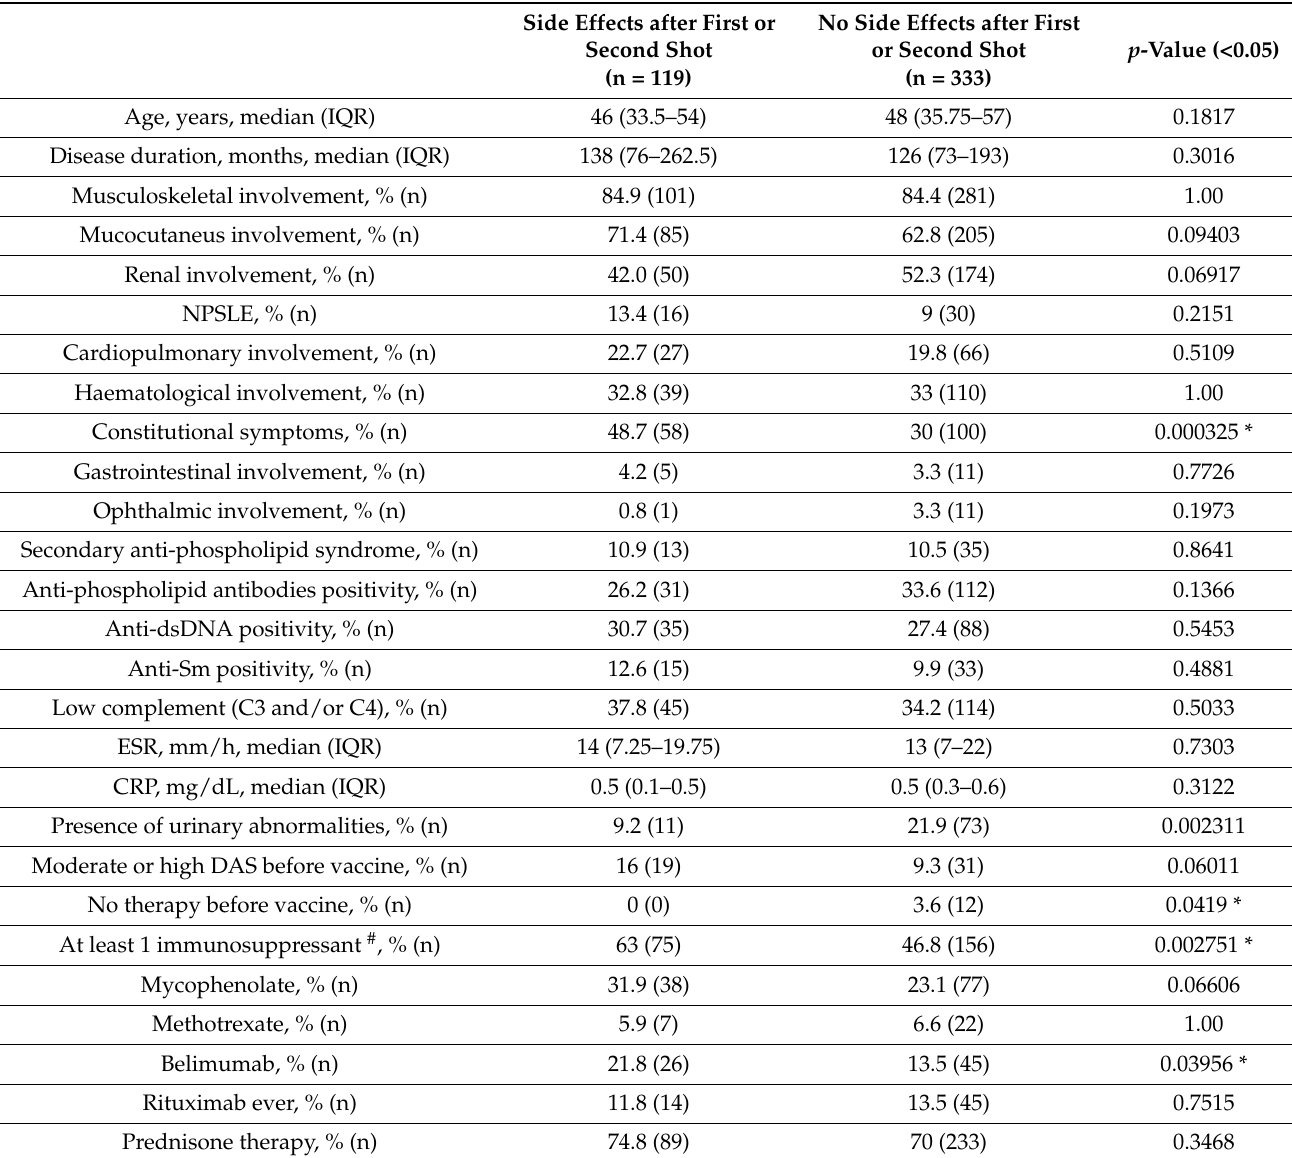
Table 3. Distribution of demographic and SLE patient characteristics according to side effects due to SARS-CoV-2